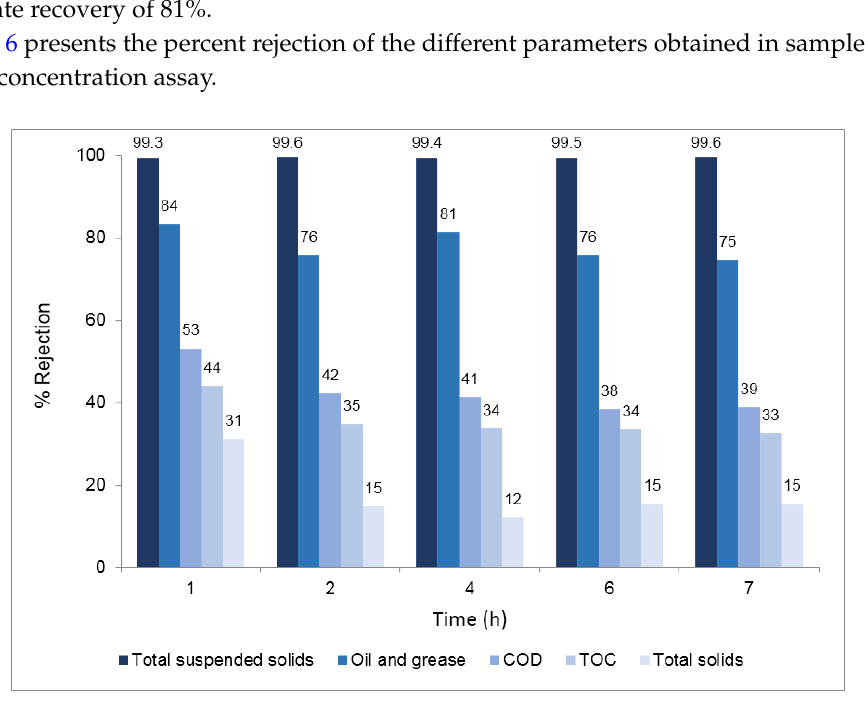
Figure 6. Percent rejection of total suspended solids, oil and grease, chemical oxygen demand (COD), total organic carbon (TOC) and total solids—Concentration test.